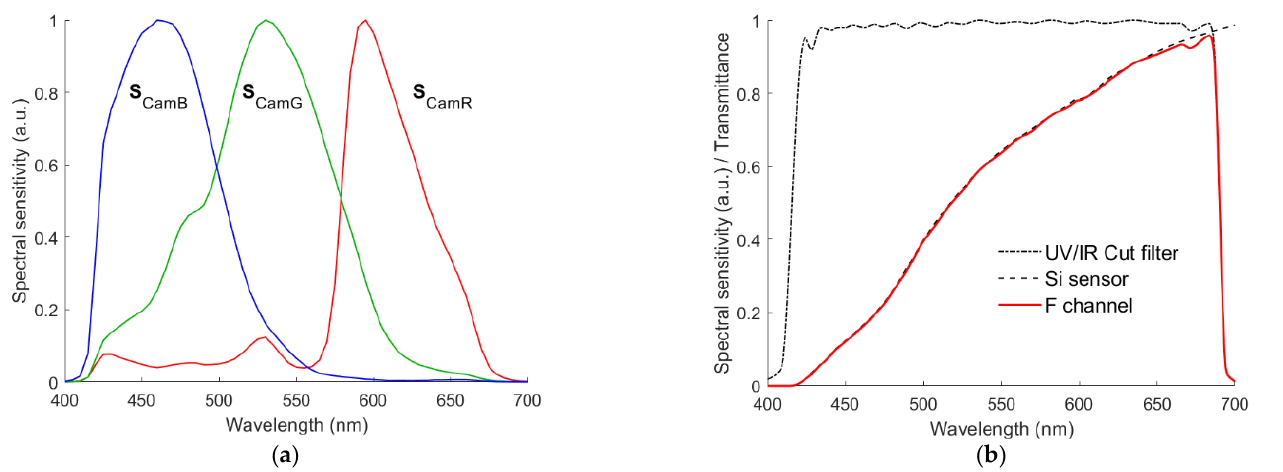
Figure 2. ( a ) Spectral sensitivities of the Nikon D5100 camera, where the spectra S CamR , S CamG and S CamB are the sensitivities of the red, green and blue signal channels, respectively. ( b ) Spectral sensitivity of the F signal channel that is the product of the spectral sensitivity of a typical silicon sensor and the spectral transmittance of the Baader UV/IR cut filter.